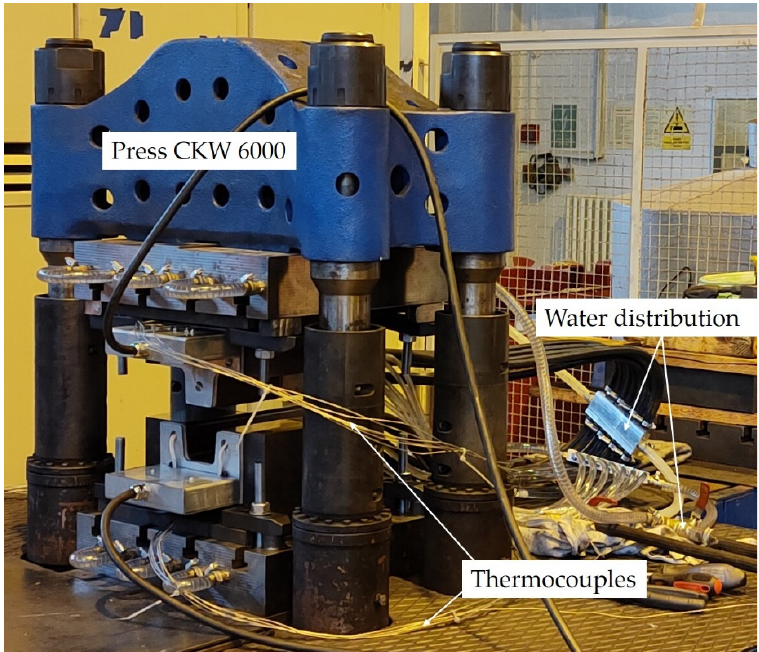
Figure 4. Workplace with the combined tool including all the accessories.